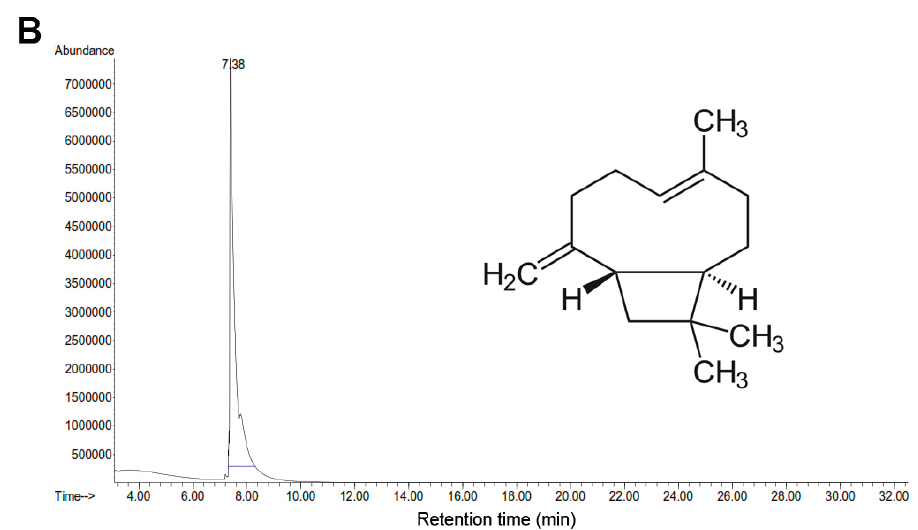
Figure 2. Gas chromatograpic analysis of Aquilaria crassna and β -caryophyllene. ( A ) Chemical characterization of the essential oil of Aquilaria crassna by GC-MS. The pie